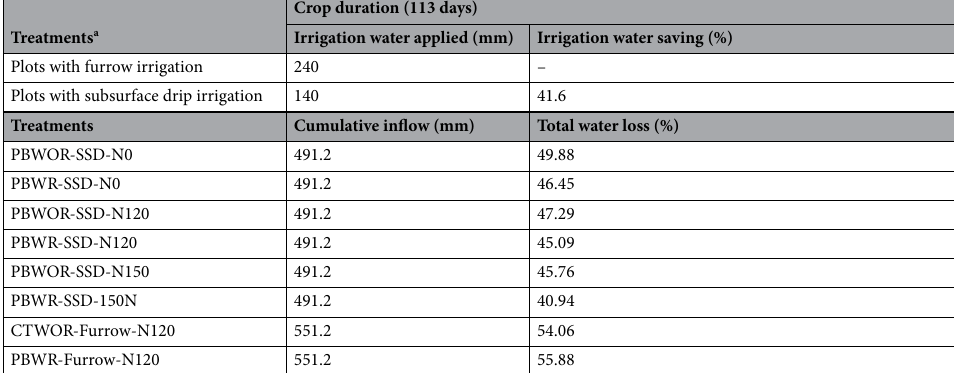
Crop duration (113 days)